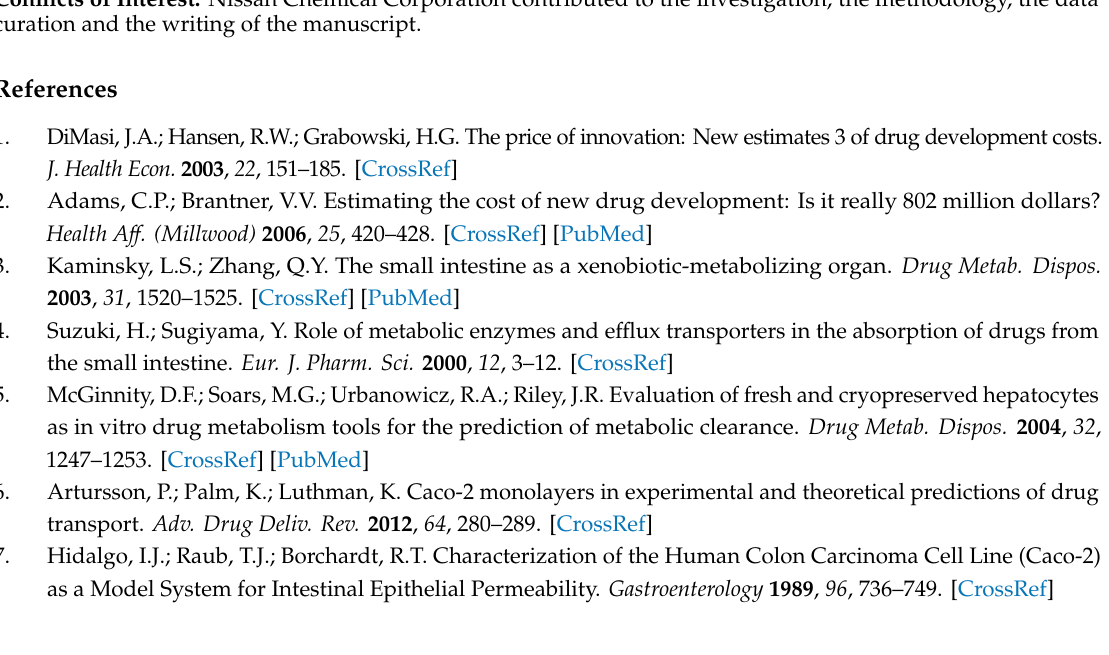
Figure S1: The comparison of various kinds of fiber on enterocyte di ff erentiation from human iPS cells. Figure S2: The e ff ect of various GG concentrations on gene expression in iPS cell-derived enterocytes at the end of di ff erentiation. Figure S3: The e ff ect of GG on the number of iPS cell-derived enterocytes at the end of di ff erentiation. Figure S4. The e ff ect of GG on the cell cycle analysis of iPS cell-derived enterocytes at the end of di ff